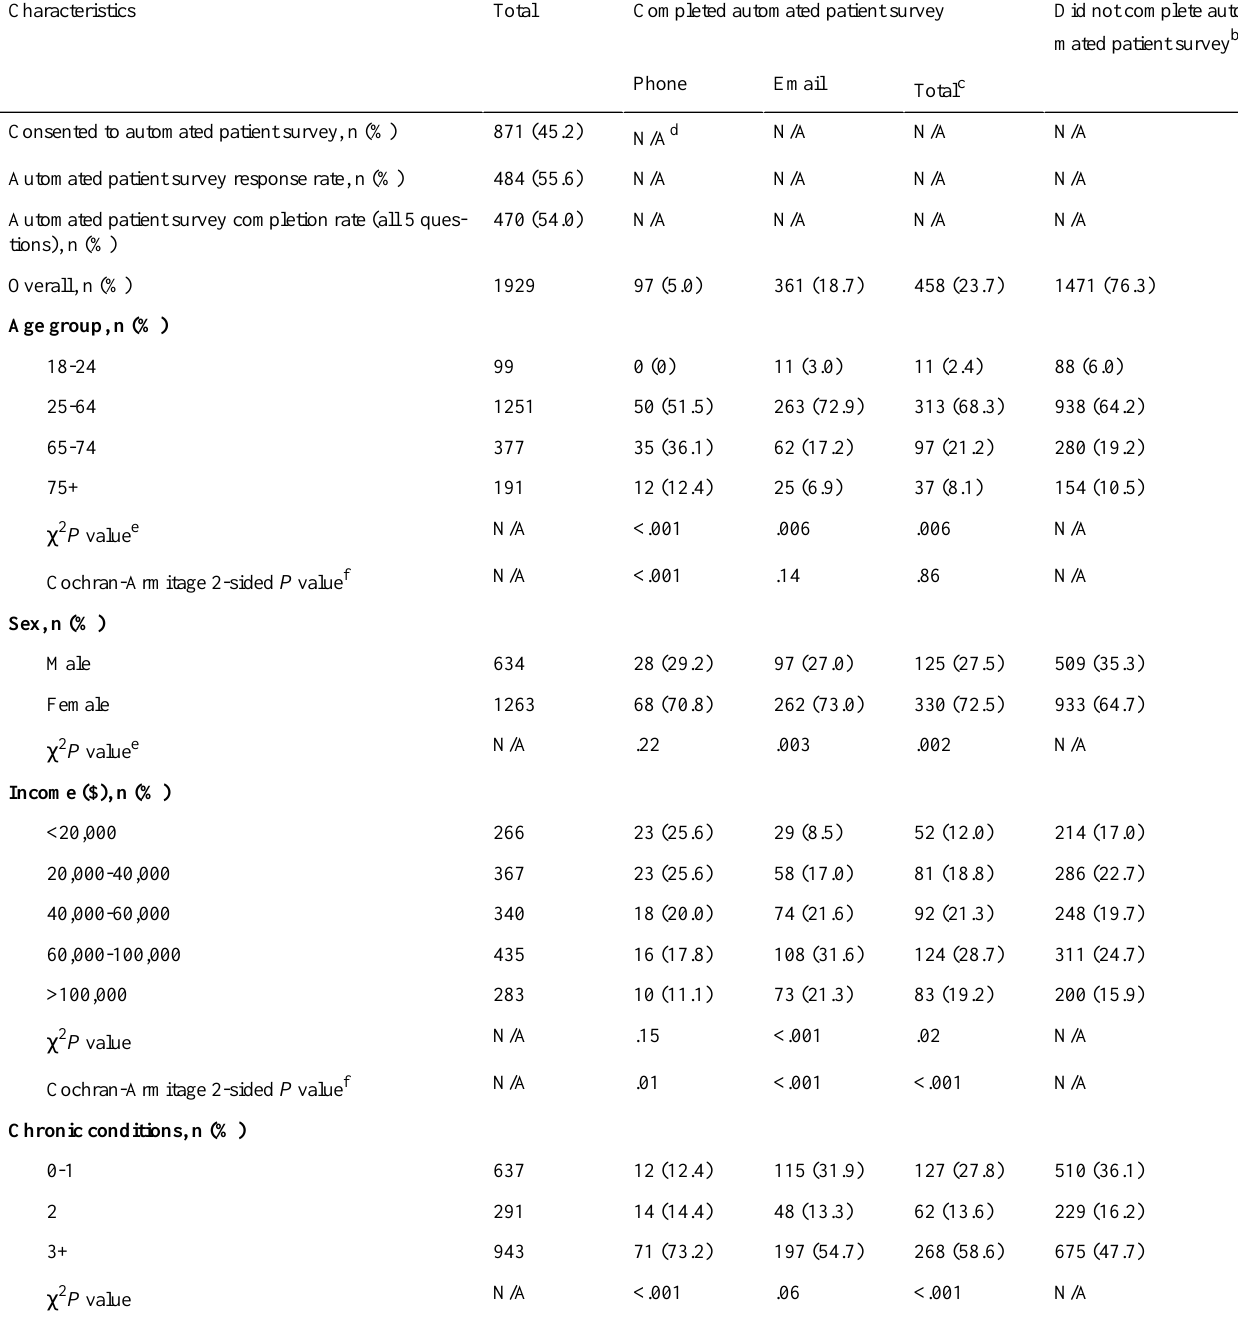
Table 1. Comparison of those who completed the automated patient survey to those who did not a .